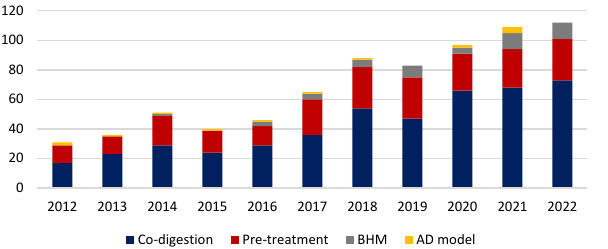
Figure 1. Number of studies focused on biogas and methane production from sewage sludge in the last 10 years.